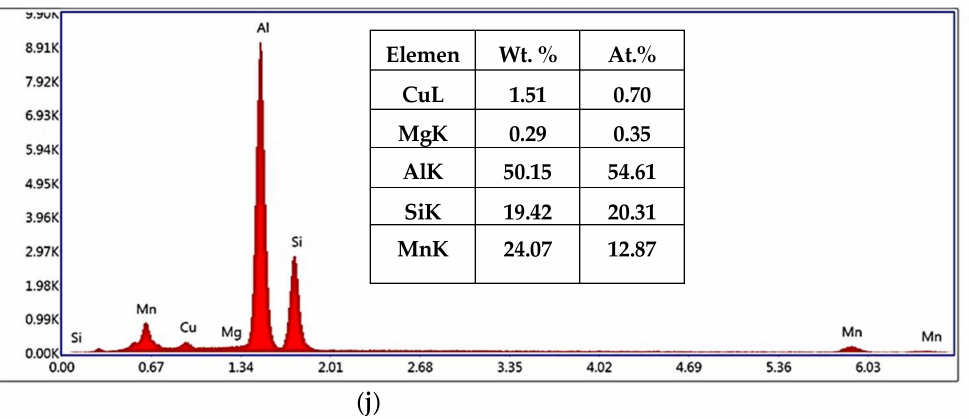
Figure 12. ( a ) Backscattered electron image of T6-treated M3S alloy after stabilization at 250 ◦ C for 200 h; ( b – h ) corresponding X-ray maps showing distribution of elements in ( a ): ( b ) map of all elements, ( c ) Al, ( d ) Mg, ( e ) Si, ( f ) Zr, ( g ) Ti, ( h ) Mn; ( i ) EDS spectrum corresponding to spot #1 in ( a ); ( j ) EDS spectrum corresponding to spot #2 in ( a ). To arrive at a better understanding of the effect of increasing the Ni content to 4% (i.e., M4S alloy) on the precipitation hardening, Figure 13 shows how the Ni-Cu interac- tion would lead to formation of Al-Ni-Cu intermetallics and hence reduce the effective- ness of Cu as a hardening agent compared to a Ni-free alloy [44], as in the case of M1S alloy shown in Figure 14 (T6 condition).